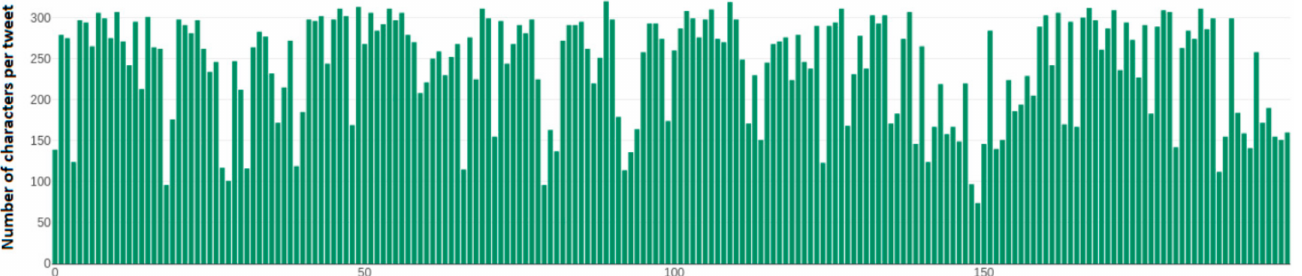
Figure 13. Text length per tweet taken from @ fofigennimata (200 tweet sample).